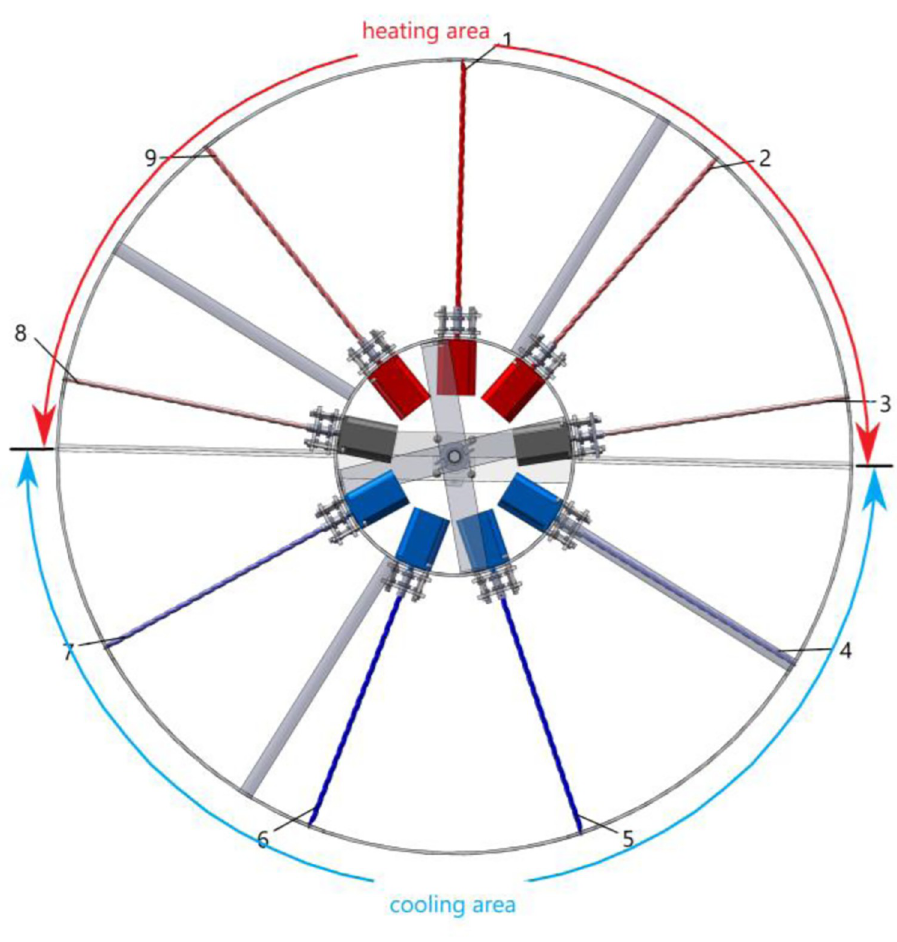
Fig 3. Heating and cooling zone diagram of the continuous torsional refrigeration